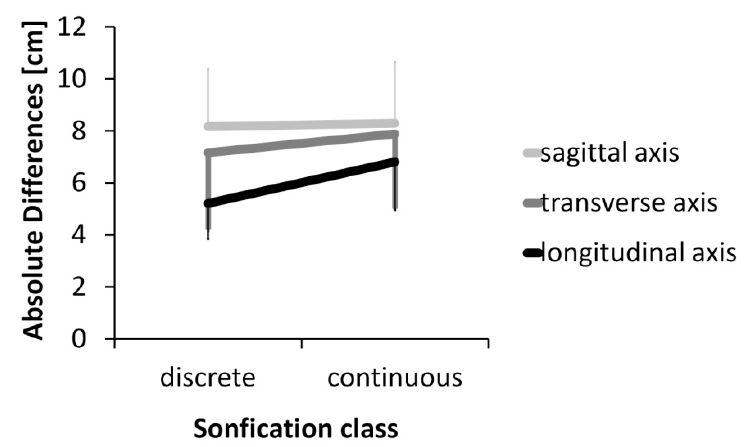
Figure 8. Means of absolute differences for the two sonification classes considered separately for the three axes.